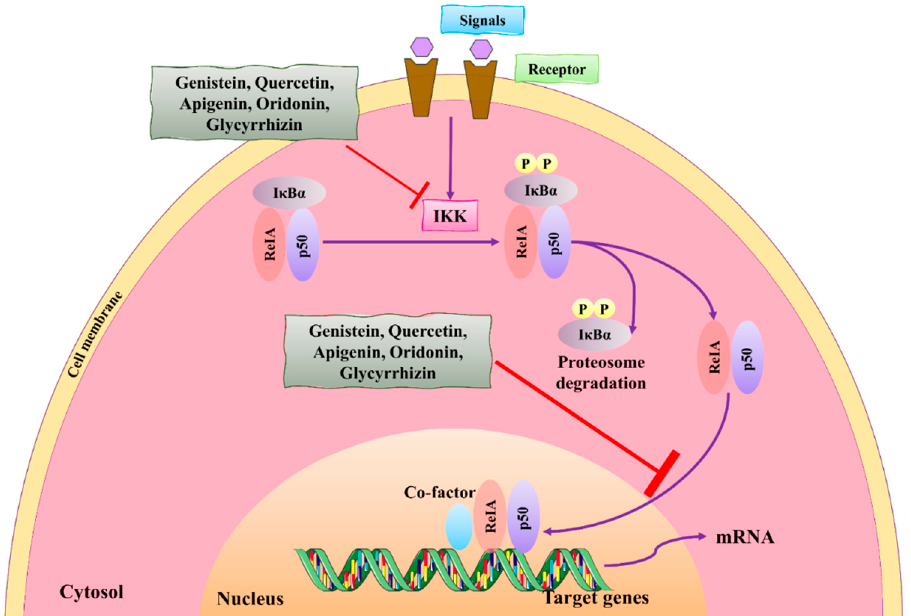
Figure 4. The role of natural compounds in the treatment of BC by regulating the NF- κ B signaling pathway and by suppressing the transcription of NF- κ B-targeted genes. IKK: I κ B kinase. This figure is reproduced from Ganesan et al. [76] after gaining permission from Elsevier (license no. 5310141484610).